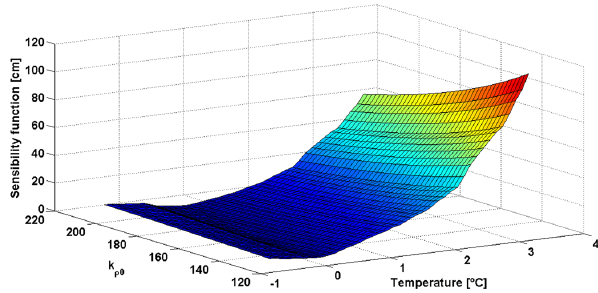
Fig. 6. Static sensitivity analysis of the model for the parameters T 0 (threshold temperature) and k ρ 0